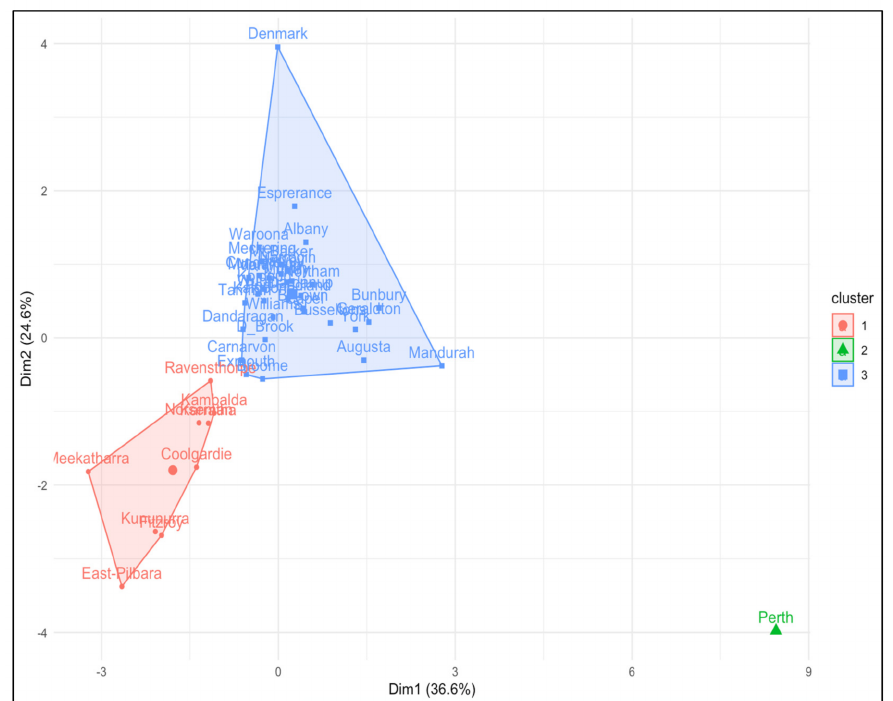
Figure 3. The K-means clustering of